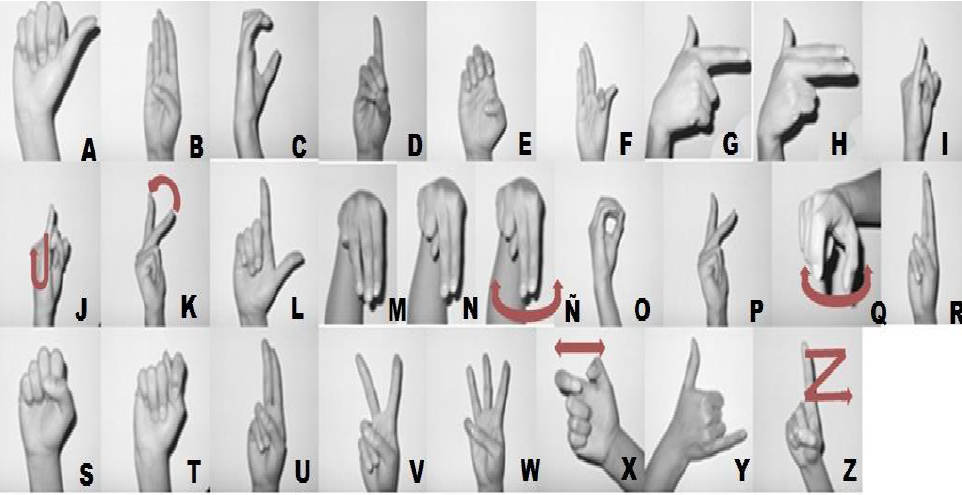
Figure 1. Sign language alphabet. The six letters drawn with arrows are dynamic. Other authors include three additional dynamic letters: CH, LL, and RR [8]. The remaining 21 letters are the static signs that are recognized in this work.